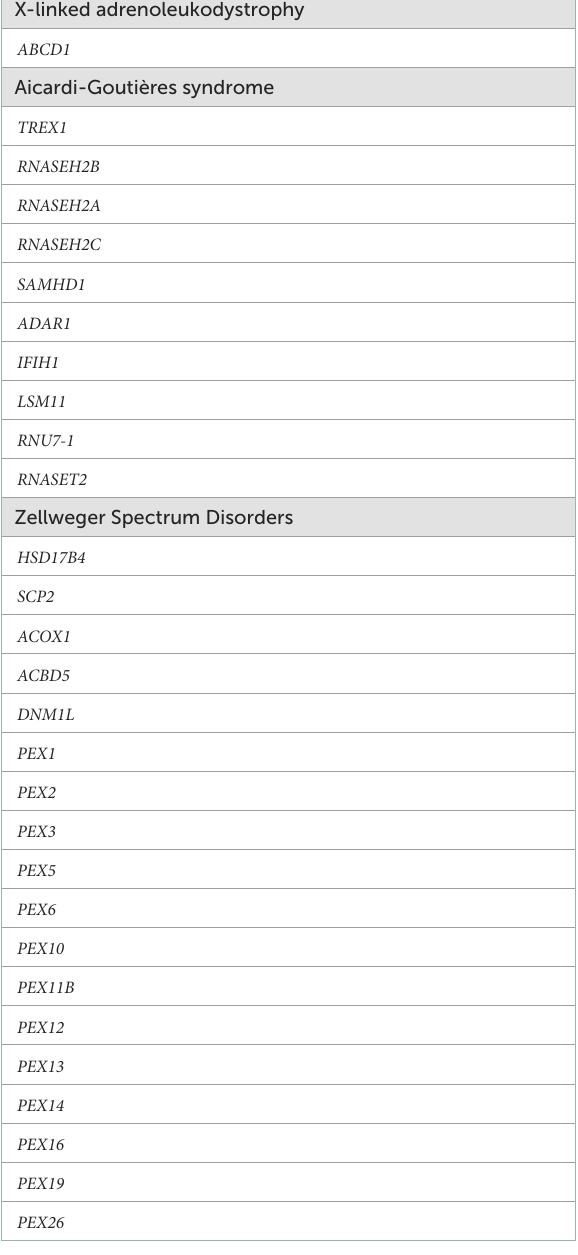
TABLE 1 Peroxisomal and Aicardi-Goutières syndrome